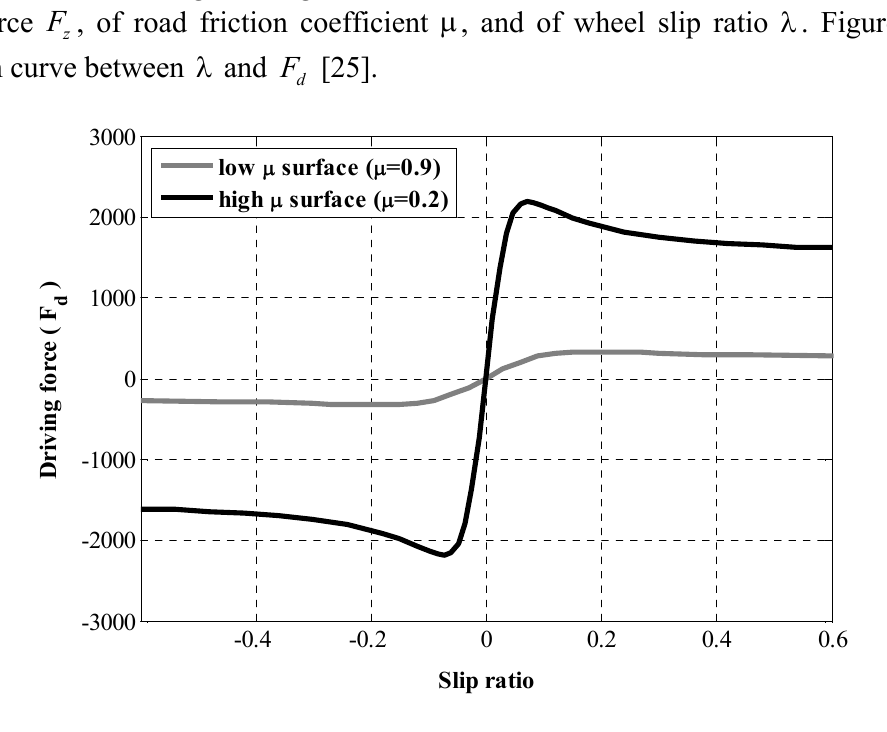
Figure 4. Relation curve between slip ratio (  ) and driving force (